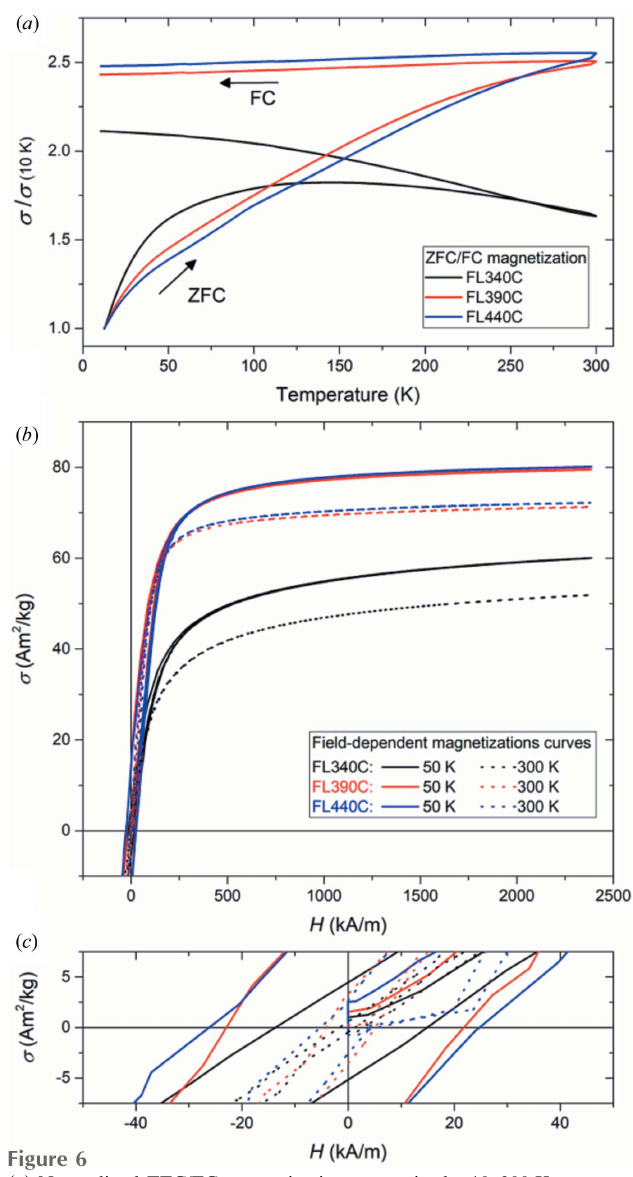
Figure 6 ( a ) Normalized ZFC/FC magnetization curves in the 10–300 K tempera- ture range in an applied field of 40 kA m (cid:5) 1 . ( b ) Field-dependent magnetization curves of the nanopowders collected using a VSM at 50 K (solid lines) and 300 K (dashed lines). ( c ) An enlarged view of the low-field region illustrating the difference in the coercive fields of the